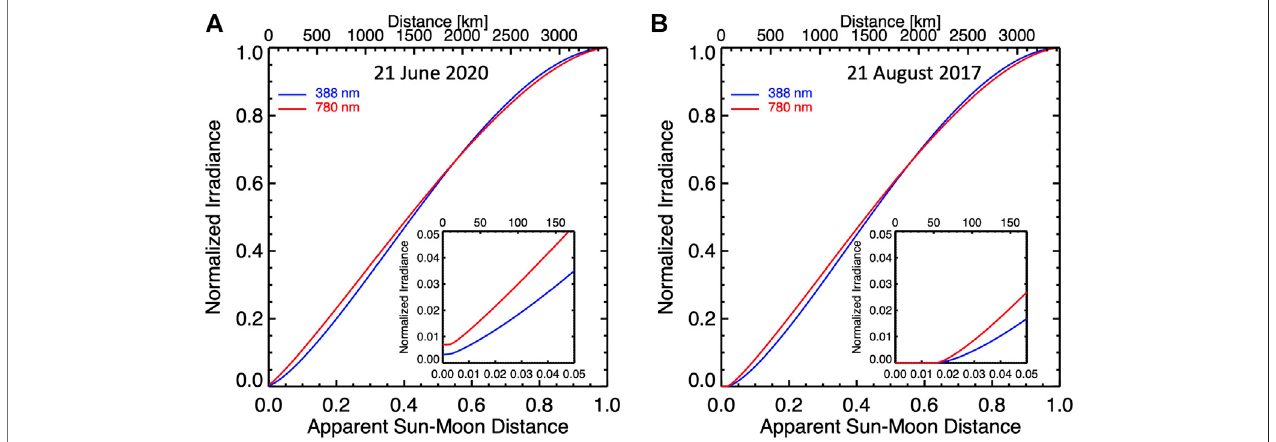
FIGURE 3 | (A) Normalized solar irradiance as a function of apparent Sun-Moon distance in lower X-axis and the distance to the center of the Moon ’ s shadow in upper X-axis on the Earth for the 21 June 2020 eclipse; (B) similar to (A) but for the 21 August 2017 eclipse. The insets show details of the irradiance variation near the center of the